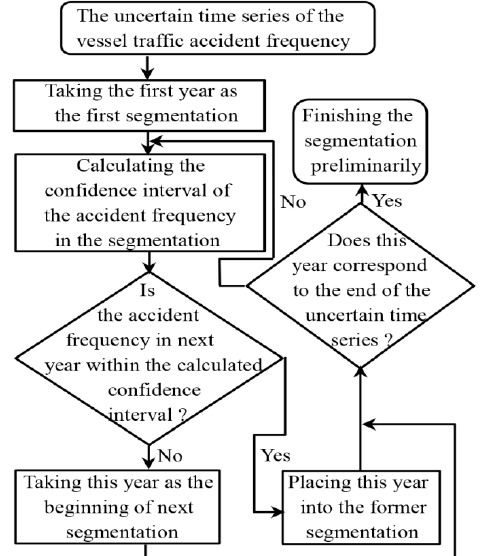
Figure 1. Flowchart for splitting uncertain time series.